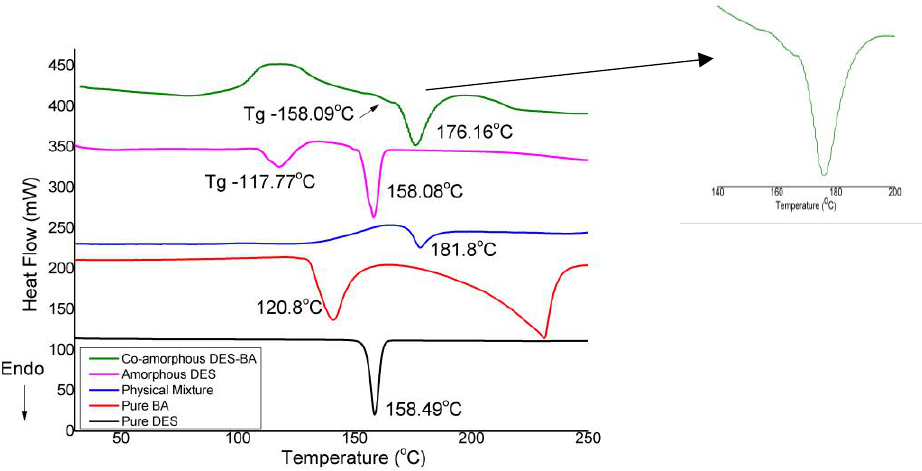
Figure 2. DSC thermograms of pure desloratadine (DES) (black line), pure benzoic acid (BA) (red line), physical mixture (blue line), pure amorphous DES (pink line), and co-amorphous DES–BA (green line).